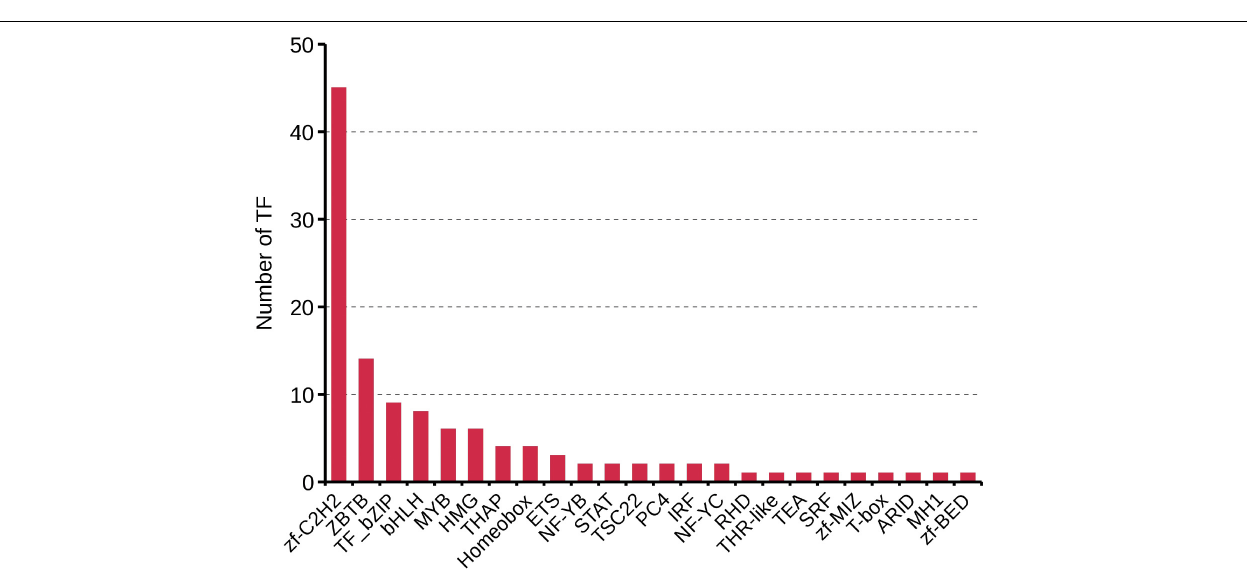
FIGURE 5 | Identification of transcription factors based on the SMRT